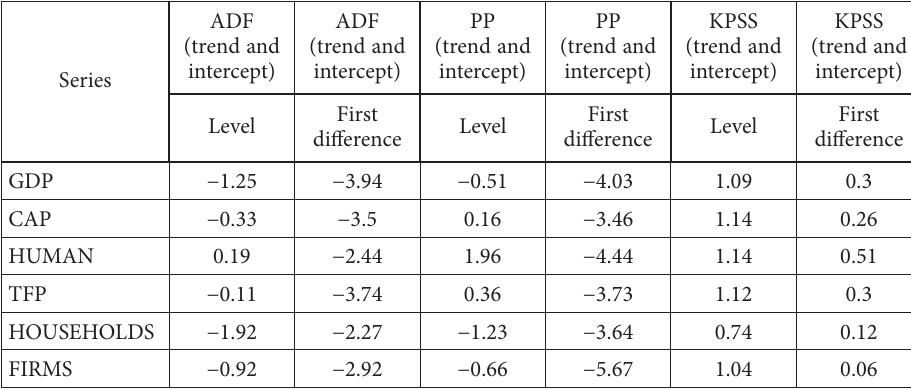
Table 2. Unit root test results (source: authors’